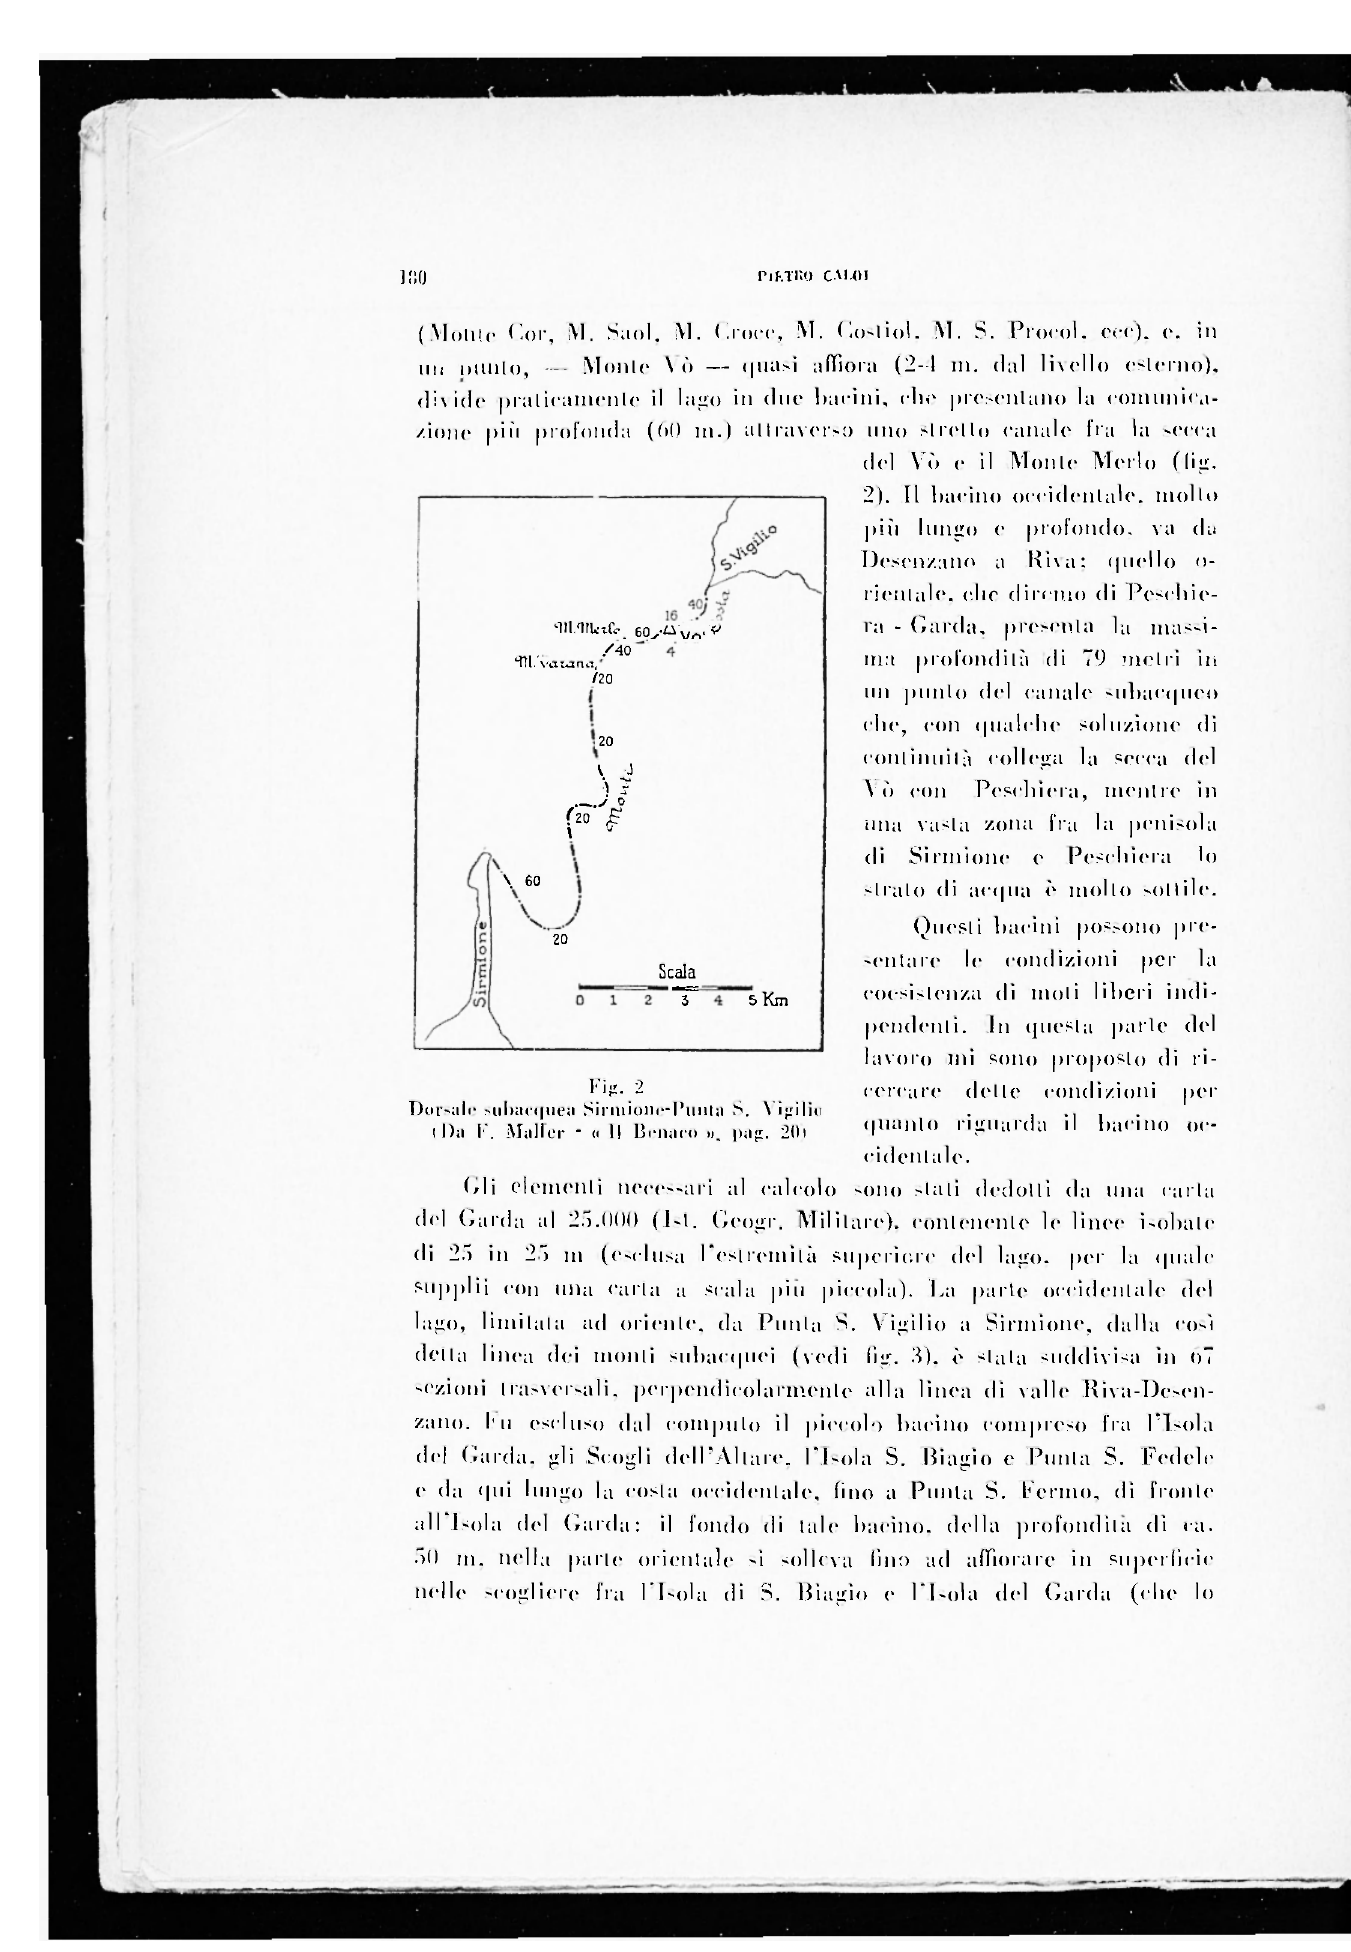
Fig. 2 Dorsale subacquea Sirmioiie-Punta S. \